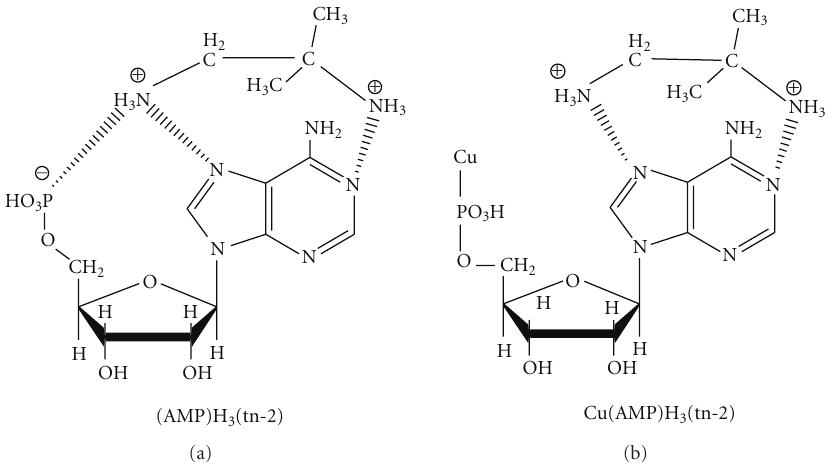
Figure 8: Tentative mode of interaction in (AMP)H 3 (tn-2) and Cu(AMP)H 3 (tn-2) complexes.